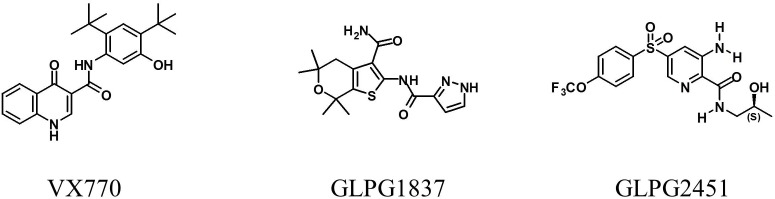
Structure of VX770, GLPG1837, and GLPG2451.